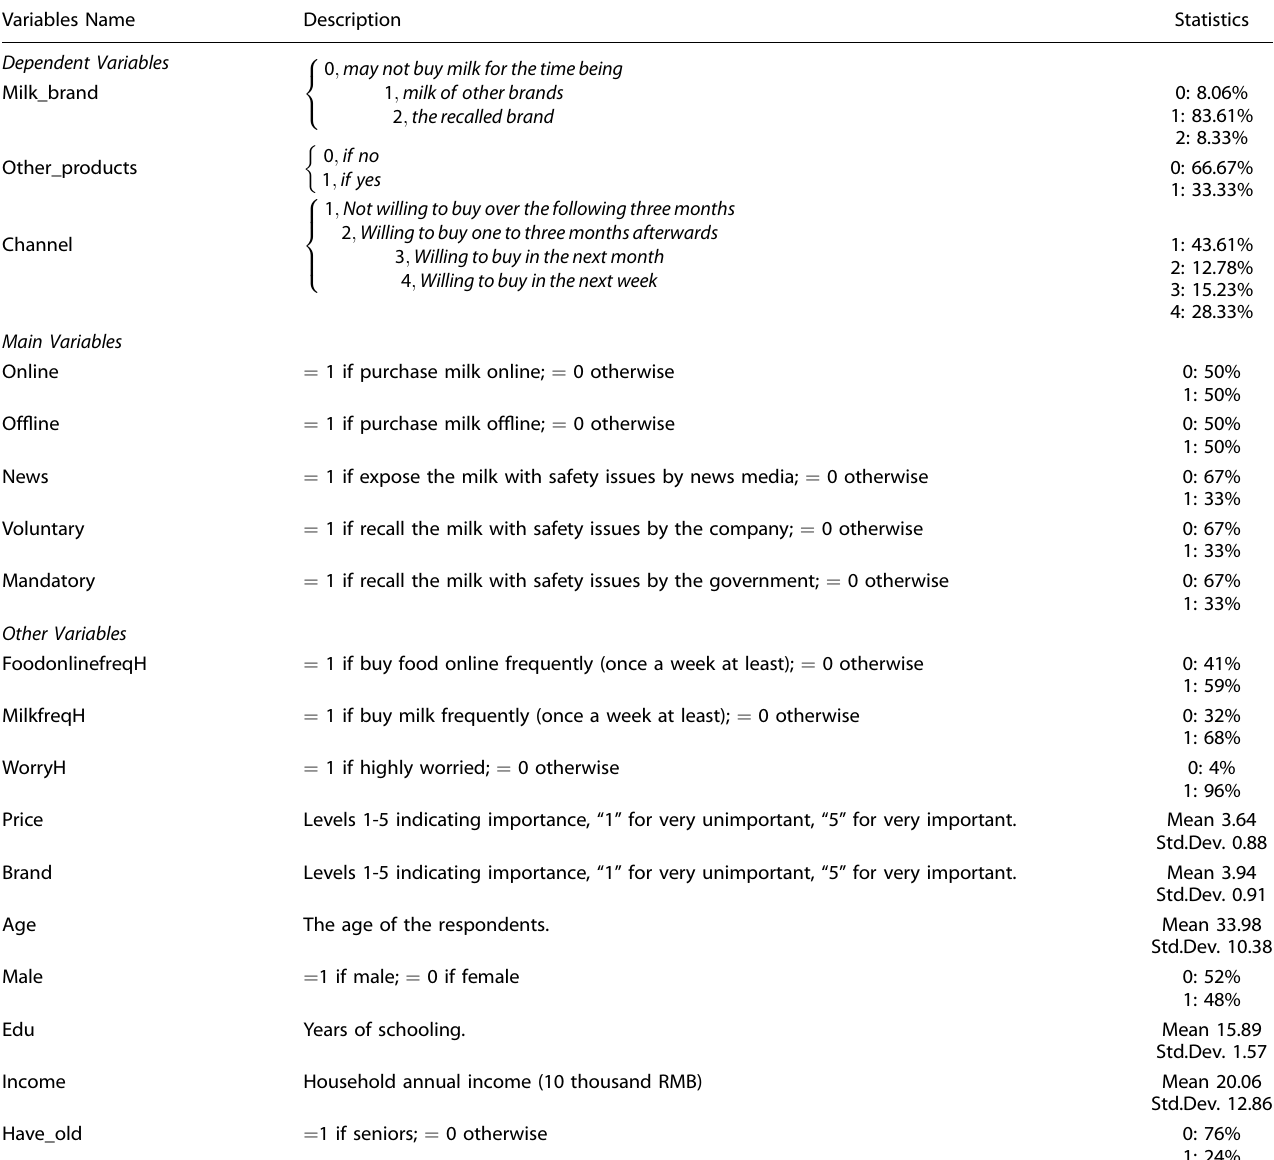
Table 1. Survey questions and summary